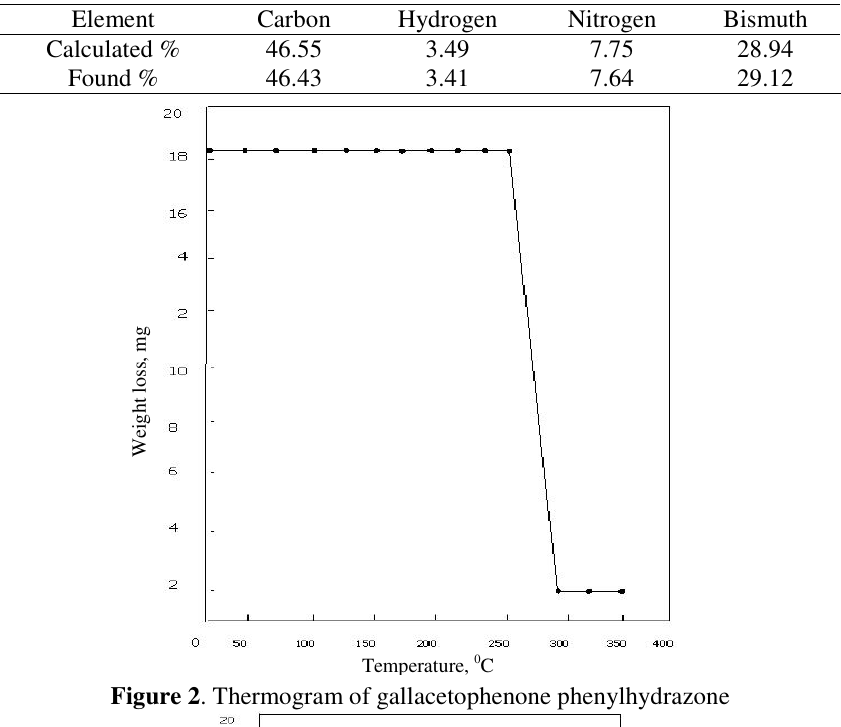
Table 3. Elemental analysis of Bi-GPPH complex